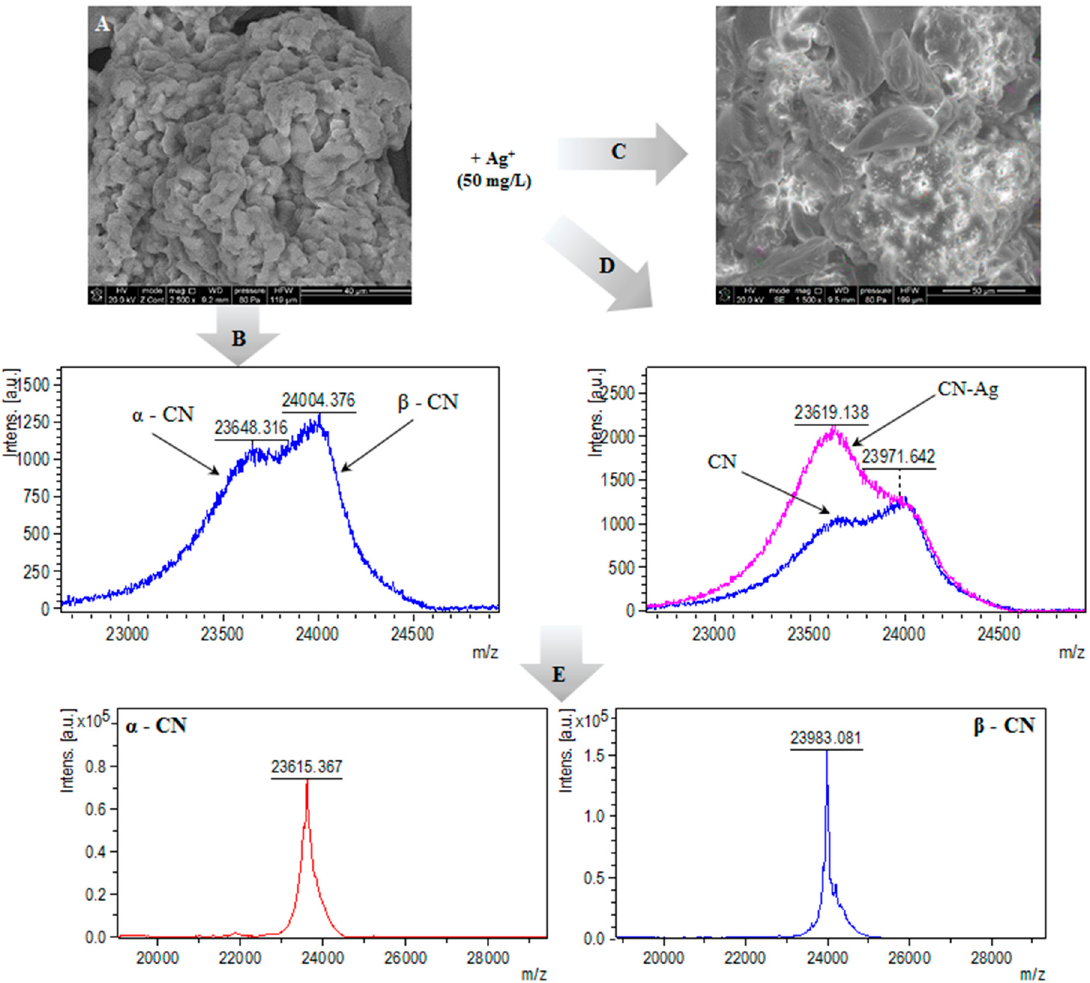
Figure 5. SEM image of native casein ( A ); mass spectrum of intact casein ( B ); SEM image of casein-silver complexes ( C ); mass spectrum of casein-silver complexes ( D ) and mass spectrum of intact α - and β -casein standard solutions ( E ), respectively.